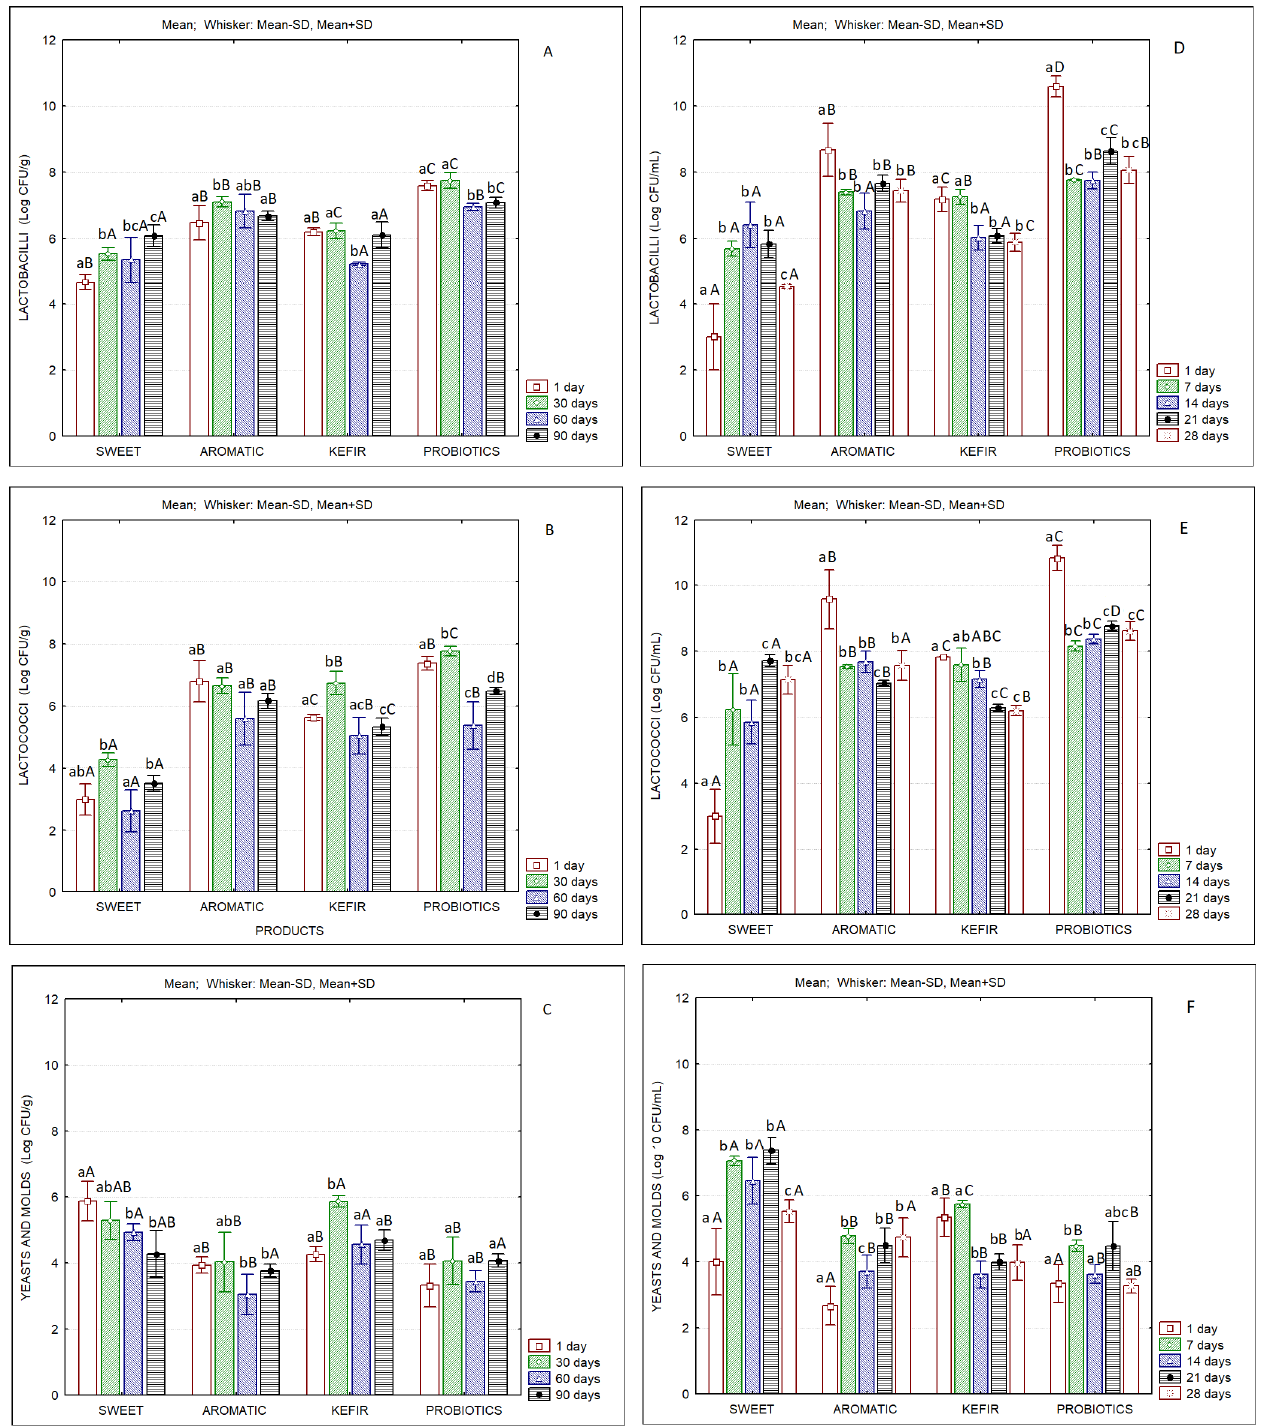
Figure 3. Microbiological characteristics of sheep’s butters and correspondent buttermilks produced with sweet cream and with cream fermented with different starter cultures. ( A ) lactobacilli in butter; ( B ) lactococci in butter; ( C ) yeasts and molds in butter; ( D ) lactobacilli in buttermilk; ( E ) lactococci in buttermilk; ( F ) yeasts and molds in buttermilk; different lowercase letters (a,b,c,d) indicate significant differences ( p < 0.05) between days of storage; different capital letters (A,B,C,D) indicate significant differences ( p < 0.05) between products at the same storage day.